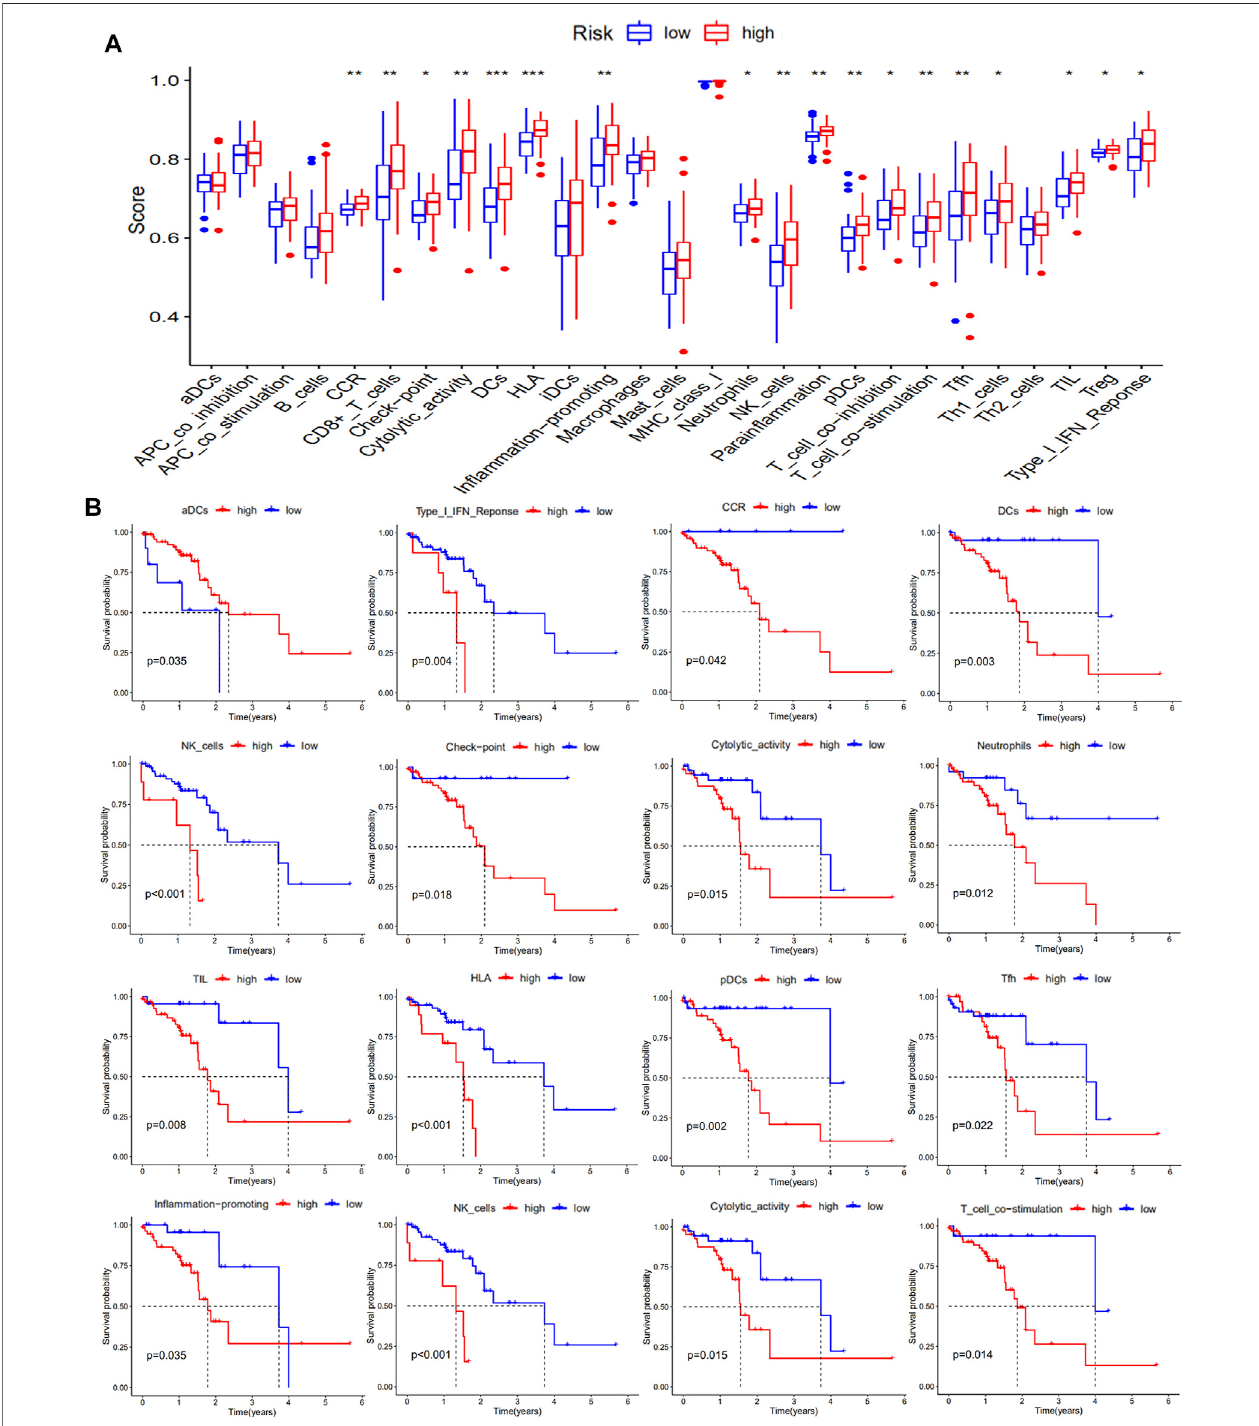
FIGURE7| Levels offunctional immunecellsand functionalmolecules inESCC patients.Thelevelsoffunctionalimmune cells and functionalmolecules areshown in (A) , and the Kaplan-Meier survival analysis is shown in (B) .